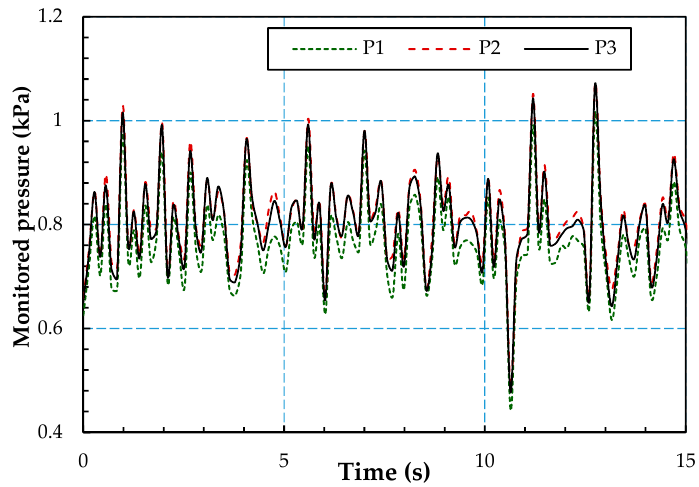
Figure 13. Pressure oscillation curves of different monitor points for Fn = 0.71.